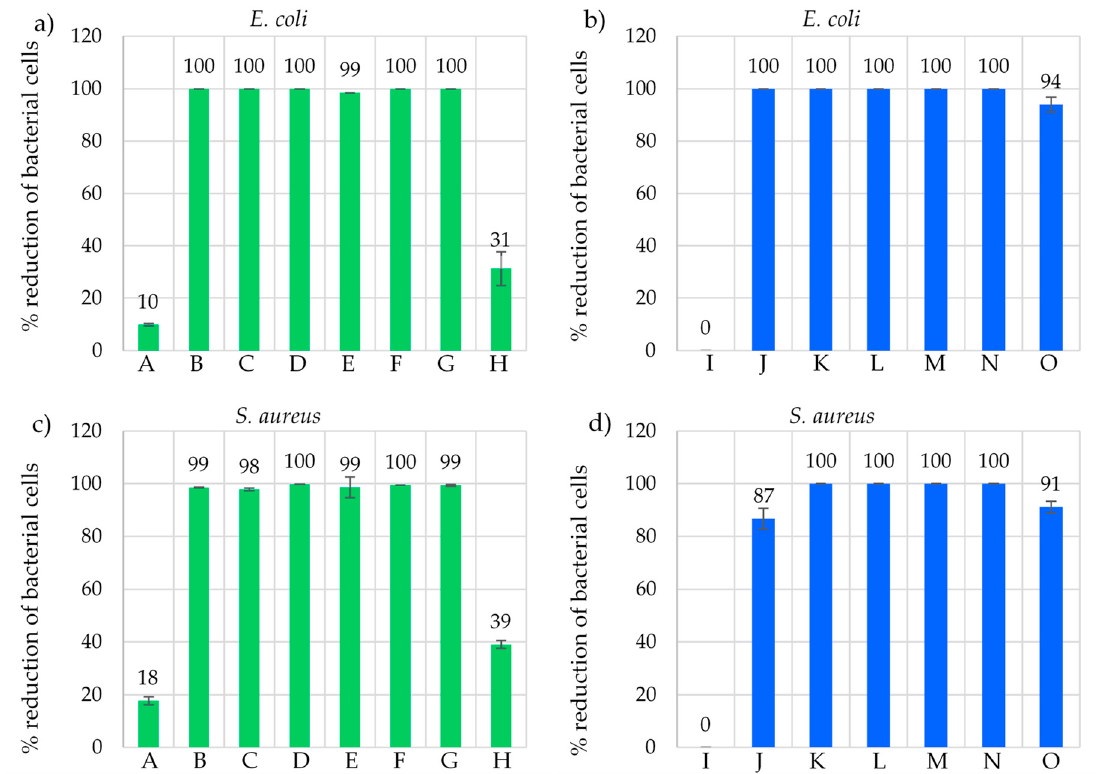
Figure 5. Antibacterial properties of PBS, PBS:FA/PA, bionanocomposites (left side), and layered double hydroxides (LDHs) (right side) against Escherichia coli ( a , b ) and Staphylococcus aureus ( c , d ). A = PBS, B = PBS:Zn 2 Al/VA, C = PBS:Zn 2 Al/FA, D = PBS:Zn 2 Al/PA, E = PBS:Zn 2 Al/FA-PA, F = PBS:Zn 2 Al/VA-FA-PA, G = PBS:Zn 2 Al/OMW, H = PBS:FA/PA, I = PuralMg61, J = Zn 2 Al/VA, K = Zn 2 Al/FA, L = Zn 2 Al/PA, M = Zn 2 Al/FA-PA, N = Zn 2 Al/VA-FA-PA, and O = Zn 2 Al/OMW.